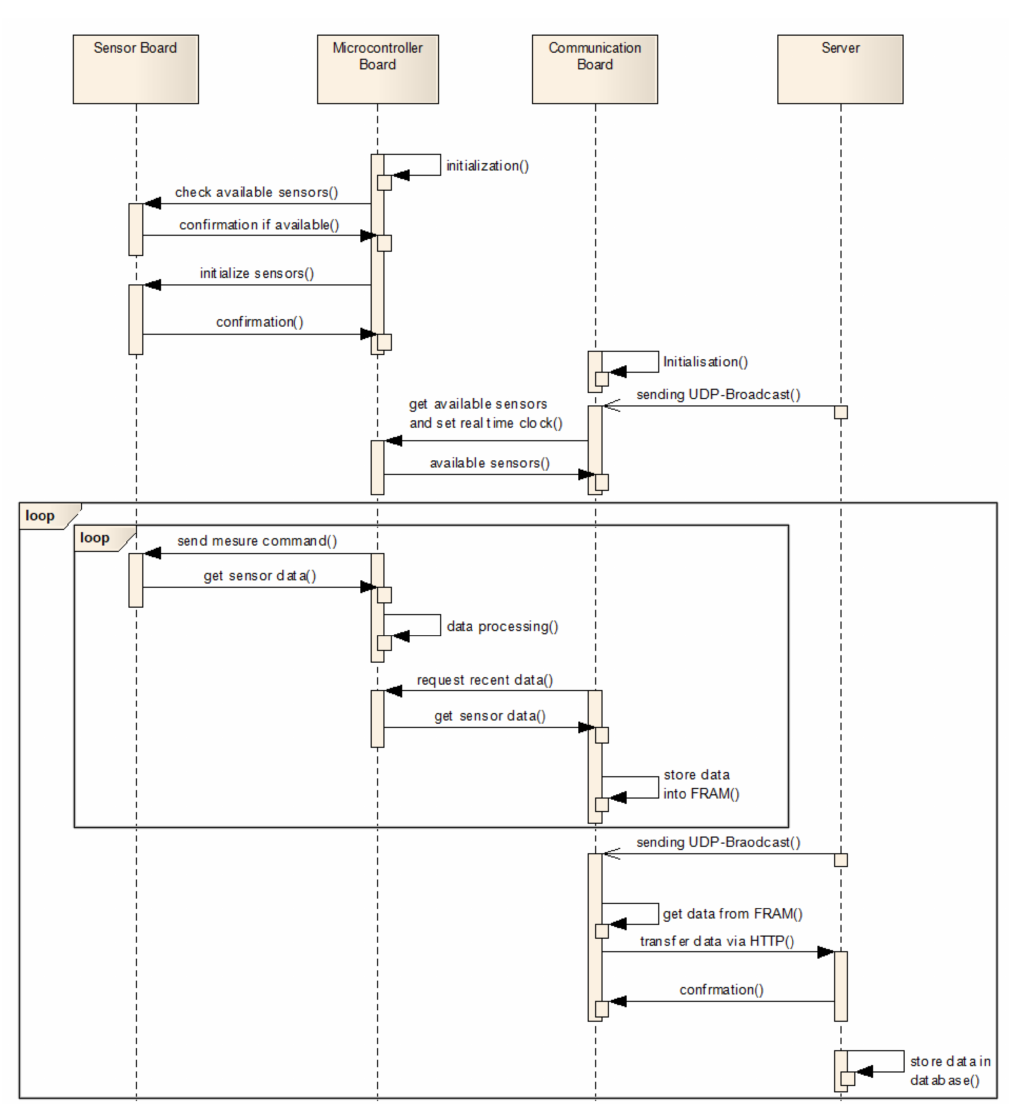
Figure 3. Simplified sequence diagram of the data transfer process between the sensor node components and the communi- cation